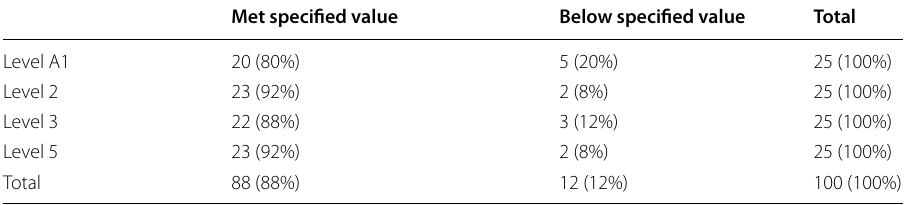
Table 4 The extent to which the 100 items meet the specified discrimination index (based on point-biserial correlations) for the reading sub-tests per test level